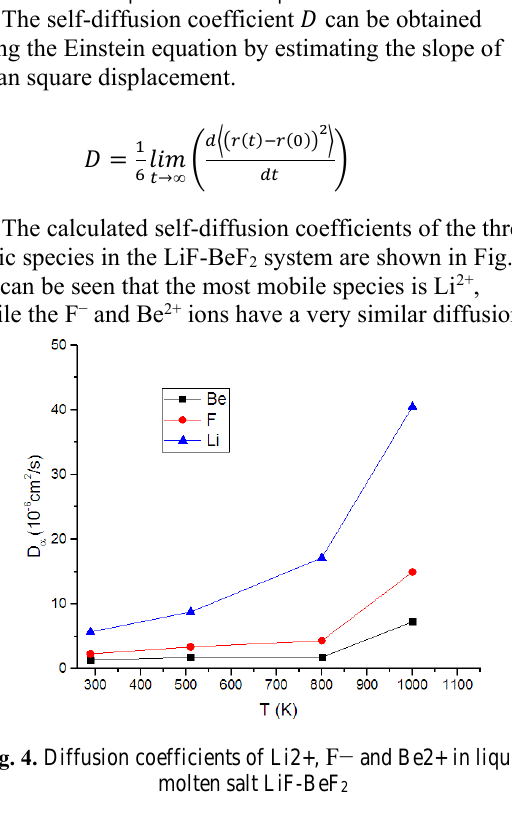
Fig. 3. Calculated density of liquid molten salt LiF-BeF 2 in comparison to the experimental data